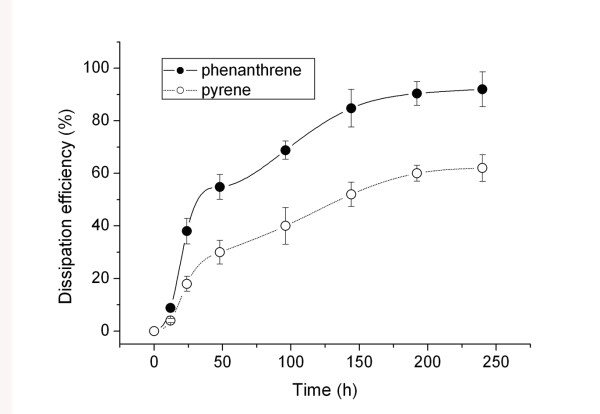
Dissipation efficiency (%) of phenanthrene and pyrene by ryegrass from aqueous solution as a function of exposure time. The values were defined as ratio of PAH removal to the initial concentration from the aqueous solution. It explained in principle the plant-affected dissipation of phenanthrene and pyrene from solution, and such dissipation was primarily related to plant accumulation and metabolism.